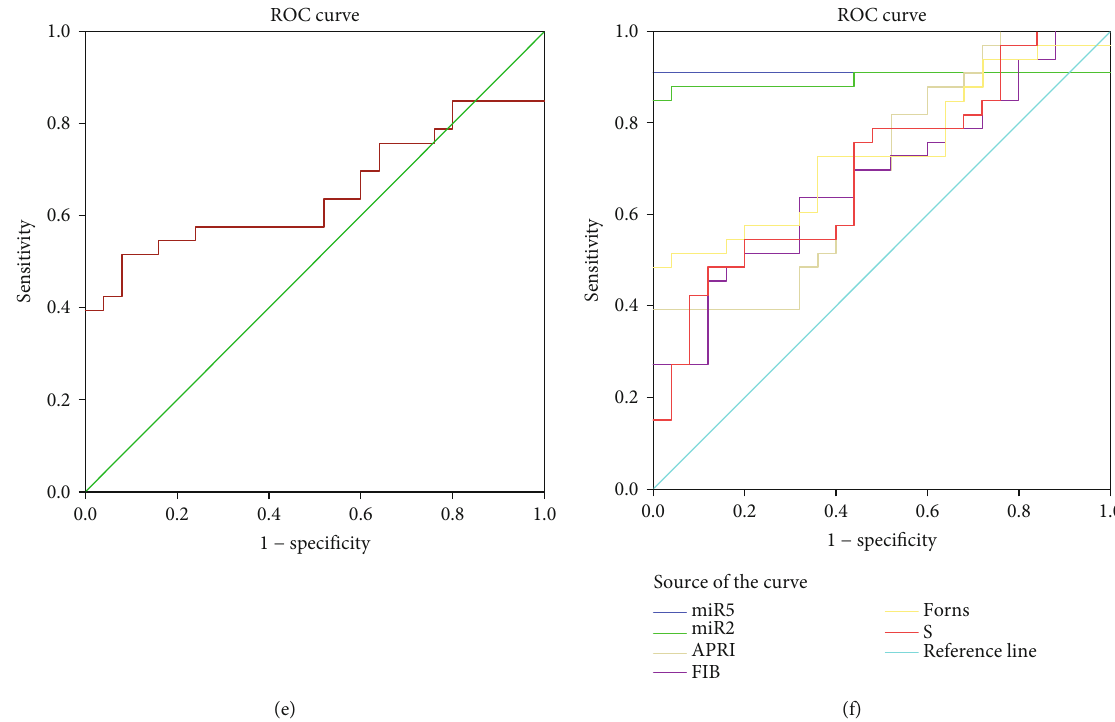
Figure 4: ROC curve analysis. ROC curve of hsa-mir-1225-3p (a), hsa-mir-1238 (b), hsa-miR-3162-3P (c), hsa-miR-4721 (d), and hsa-miR- H7 (e) in predicting signi fi cant liver fi brosis (S2-4). (f) ROC curve of diagnostic models miR-5, miR-2, APRI, FIB-4, Forns, and S in predicting signi fi cant liver fi brosis (S2-4). Table 6: Analysis of the AUROC between the miRNA-5 diagnosis model and other diagnosis